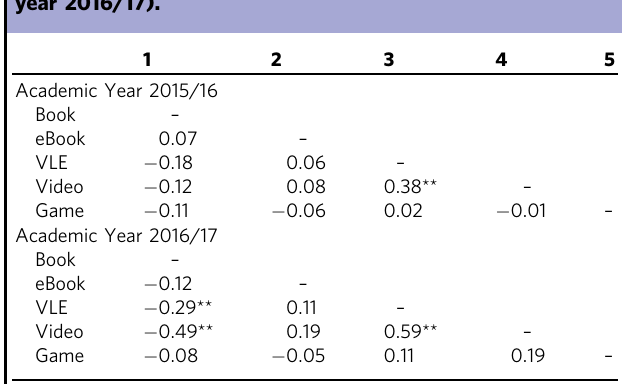
Table 2 Spearman ’ s rho correlation matrix between